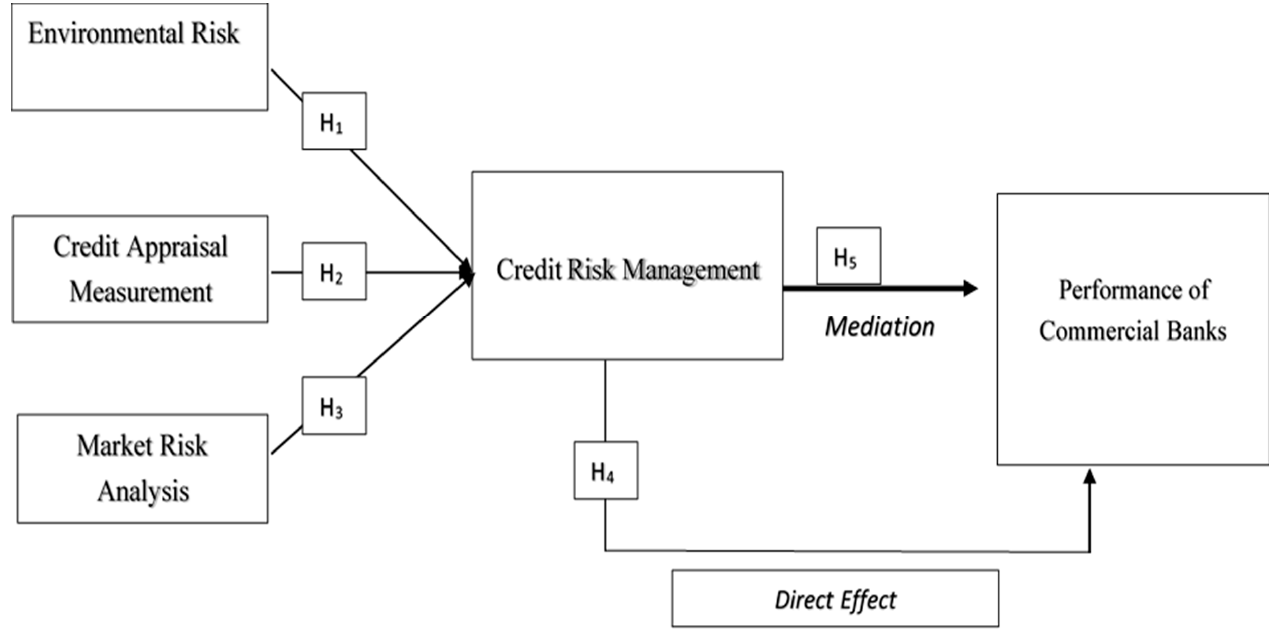
Figure 1. Conceptual model of credit risk management and bank performance.